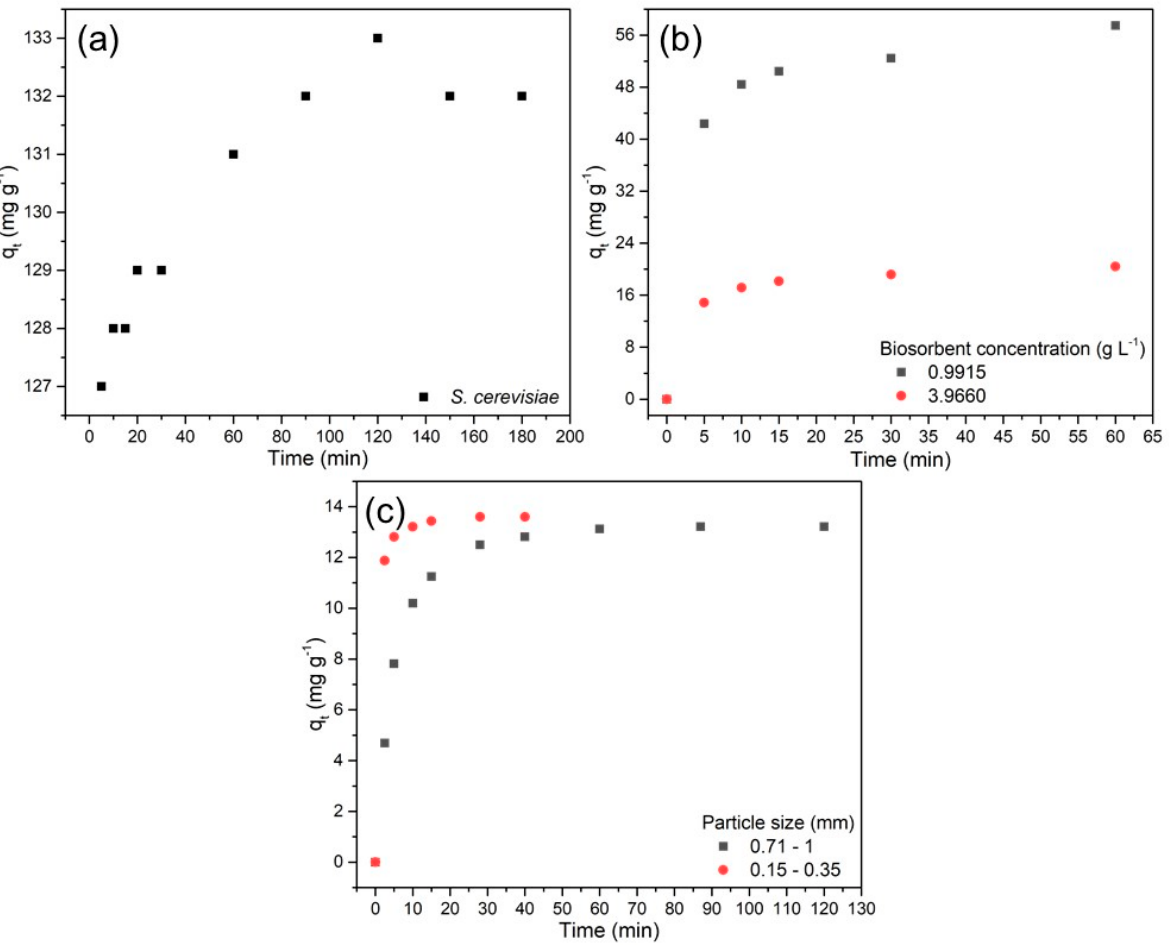
Figure 4. Adsorption curve of the Cu 2+ ion for the systems: ( a ) S1-Cu—with Saccharomyces cerevisiae [51]; ( b ) S2-Cu—with different concentrations of biosorbent [52]; and ( c ) S3-Cu—with different biomass particle sizes [53].